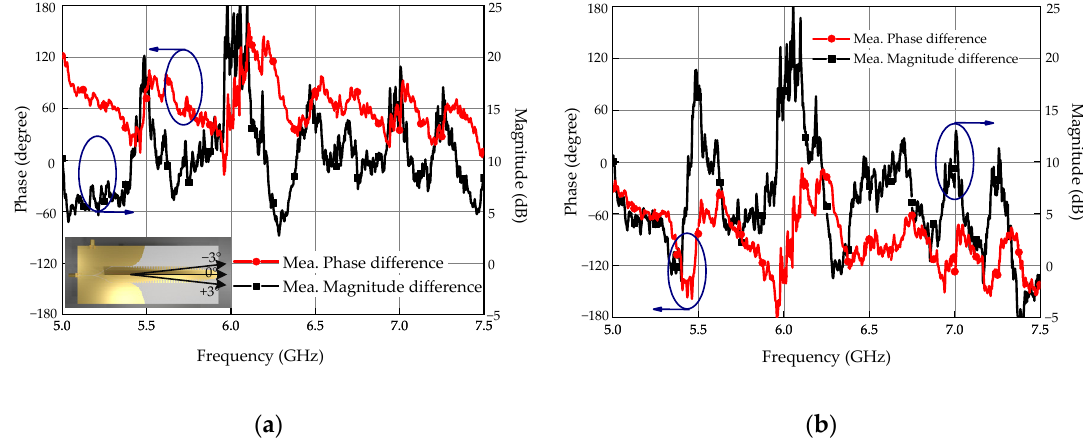
Figure 16. Measured magnitude difference and phase difference of transmission coefficient. ( a ) Magnitude difference of − 3° to 0° and phase difference of 0° to 3°; ( b ) Magnitude difference of +3° to 0° and phase difference of 0° to +3°. Purple circles indicate the corresponding axes